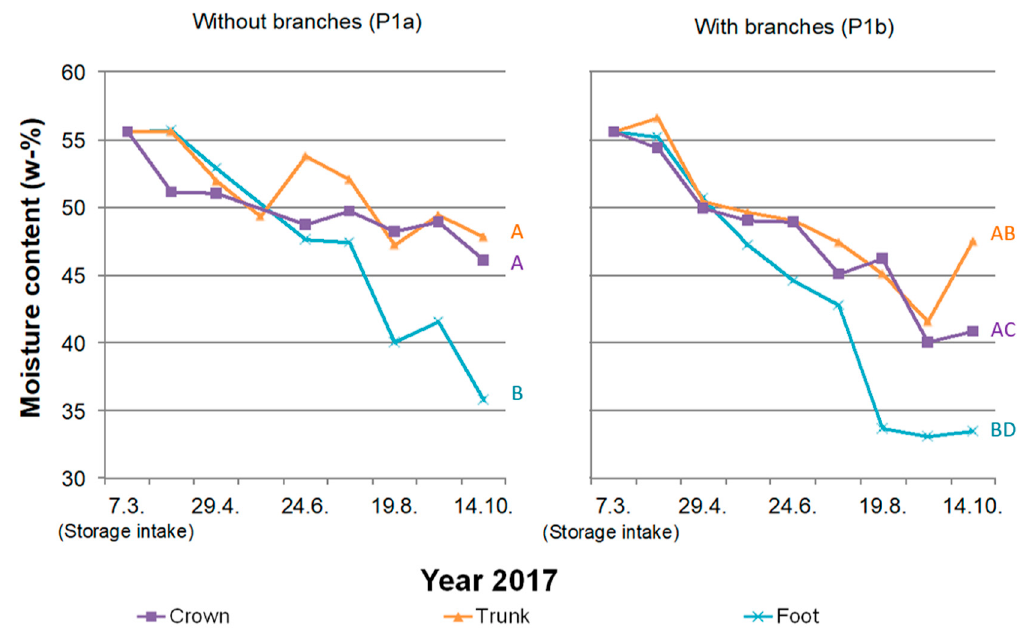
Figure 11. Development of the moisture contents for trial P1 in Potsdam depending on the tree section (Different letters indicate significant differences between treatments for α = 0.05, F-test).